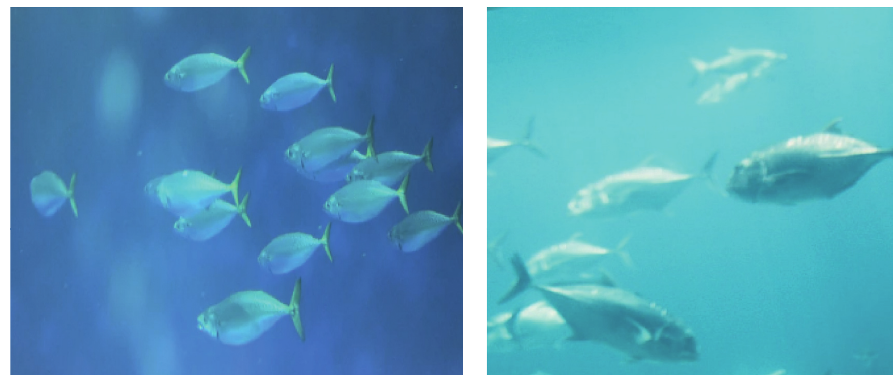
Figure 1: Image clearance within the quality of